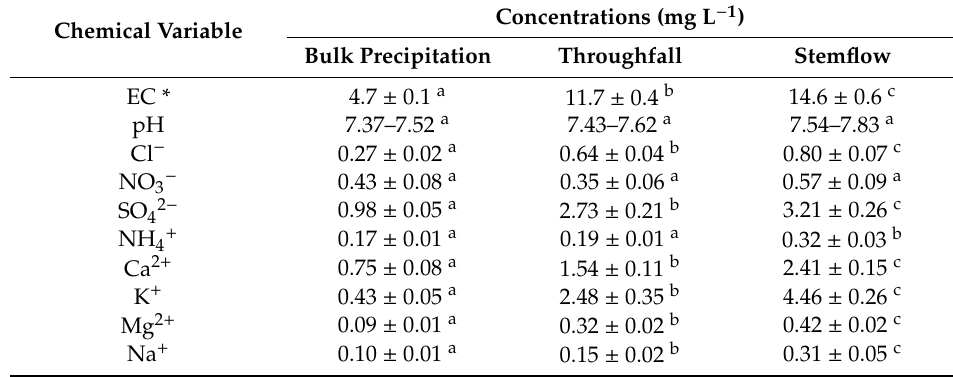
Table 1. Chemical characteristic of water in bulk precipitation, throughfall and stemflow during the monitoring period.